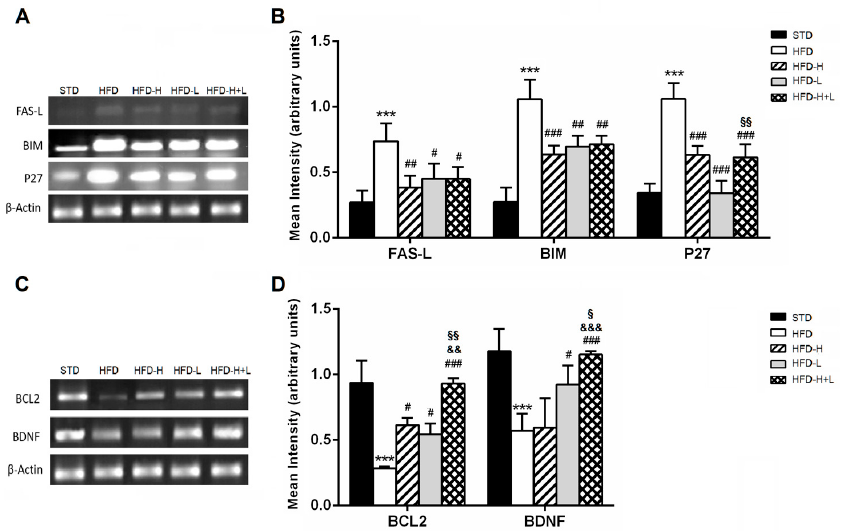
Figure 3. Apoptosis. ( A ) result of the RT-PCR and ( B ) mRNA levels of pro-apoptotic genes: FAS-L , BIM and P27 in the mouse brain of different groups; ( C ) Representative image of the RT-PCR results and ( D ) mRNA levels of survival genes: BCL2 and BDNF in the mouse brain of different groups. Data are mean values ± S.E.M. (n = 8/group). *** p < 0.001 vs. STD mice; # p < 0.05, ## p < 0.01, ### p < 0.001 vs. HFD mice; && p < 0.01, &&& p < 0.001 vs. HFD-H mice; § p < 0.05, §§ p < 0.01 vs. HFD-L mice.